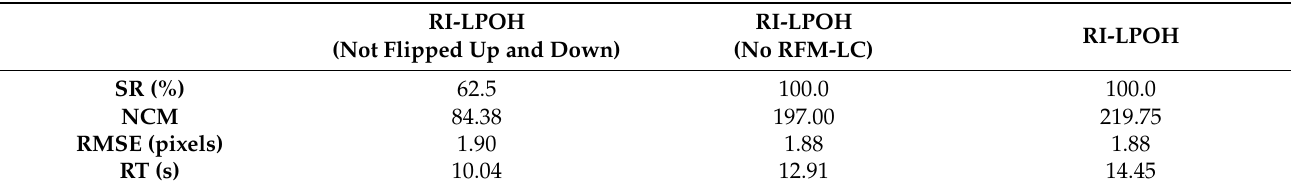
Table 8. Performance evaluation results for comparative experiments.